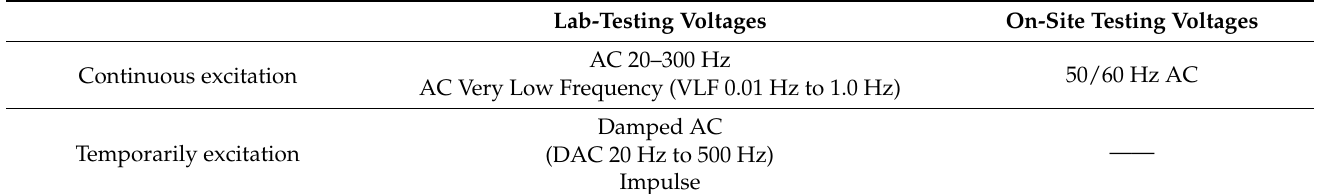
Table 1. Different voltage excitations for partial discharge (PD) detection in shielded power cable